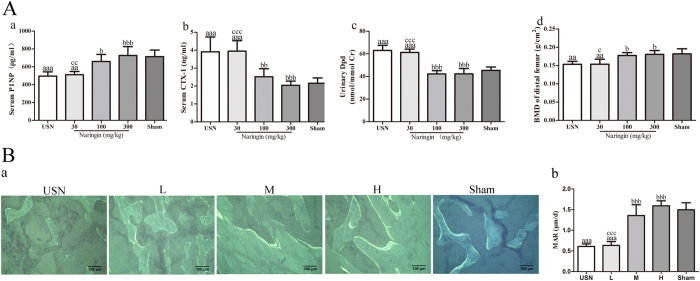
Effects of naringin on bone-turnover markers and BMD (A) and Effect of naringin on the bone formation in each group (B). The upper panel: Serum P1NP, an indicator of osteogenic activity, and serum CTX-1 and urinary Dpd, indicators of bone resorption, were measured in all of the groups using corresponding ELISA Kits. The BMD of the distal femoral metaphysis was analysed in vivo using DXA. Naringin significantly ameliorated immobilization-induced the decrease in serum P1NP (a) and increase in serum CTX-1 (b) and urinary Dpd (c). In addition, naringin maintained the BMD in the distal femur (d) (A). The lower panel: (a) Representative undecalcified sections at 4 weeks post-operation show the fluorescent-labelled bone sections through the injection of tetracycline; (b) Quantitative results of MAR reveal that naringin significantly attenuated the decreased MAR induced by neurectomy, n = 5 (B). ap < 0.05, aap < 0.01, aaap < 0.001 vs. Sham group. bp < 0.05, bbp < 0.01, bbbp < 0.001 vs. USN group. cp < 0.05, ccp < 0.01, cccp < 0.001 vs. 300 mg/kg Naringin group. L represents the 30 mg/kg Naringin group, M the 100 mg/kg Naringin group, and H the 300 mg/kg Naringin group. Magnification ×100. One-way ANOVA.